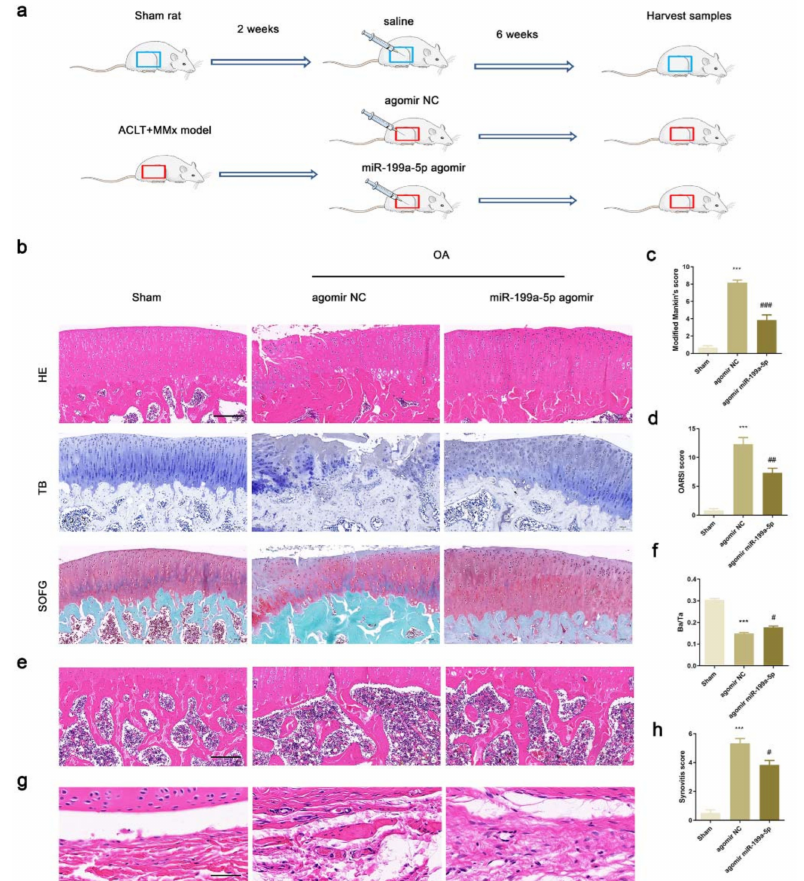
Figure 5. Intra-articular injection of miR-199a-5p attenuated OA progression in rats. ( a ) Flowchart of the experiment. ( b ) HE, TB, and SOFG staining of the articular cartilage tissues in rats. ( c , d ) Modified Mankin’s score and OARSI analysis in rats. ( e ) HE staining of subchondral bone. ( f ) The statistical ratio of bone area to the tissue area in the OA rats. ( g ) HE staining of the synovium. ( h ) Synovitis score in rats. Scale bar represents 200 µ m. HE, hematoxylin, and eosin; TB, toluidine blue; SOFG, Safranin O and fast green. Scale bar represents 100 µ m. (*** p < 0.001 versus sham group; # p < 0.05, ## p < 0.01, ### p < 0.001 versus agomir NC group; n = 6 for each